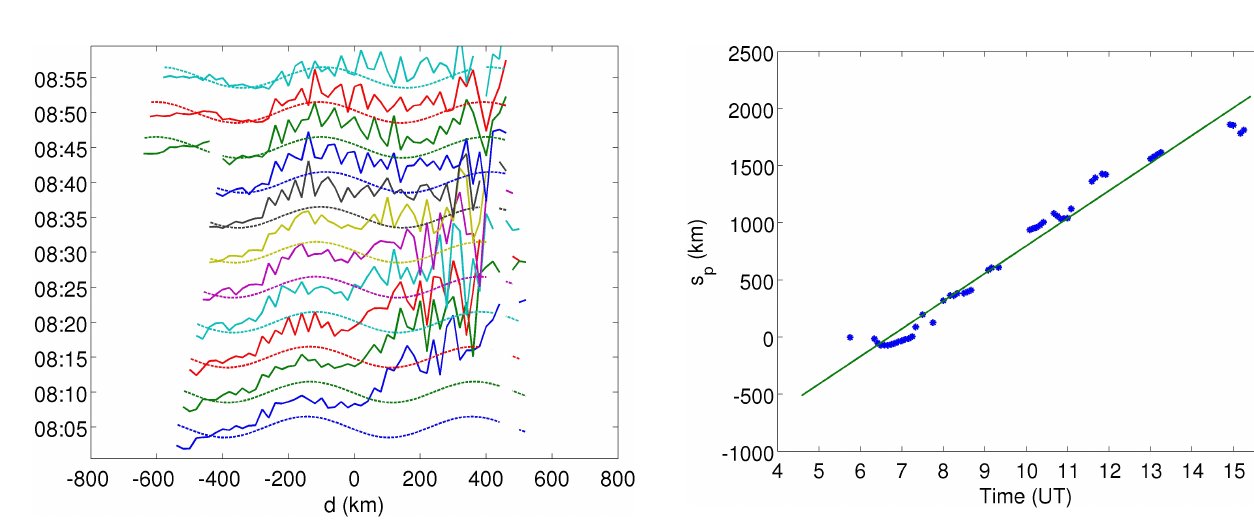
Figure 15. VTEC( d , t) between 08:00 and 09:00, as functions of the distance d along the projection line (solid lines), and waves detected from these, i.e. cosines with wavelength λ x (in this case 500km) and phases equal to arg( F) (the amplitudes are fixed to 0.1 × 10 16 electronsm − 2 ).